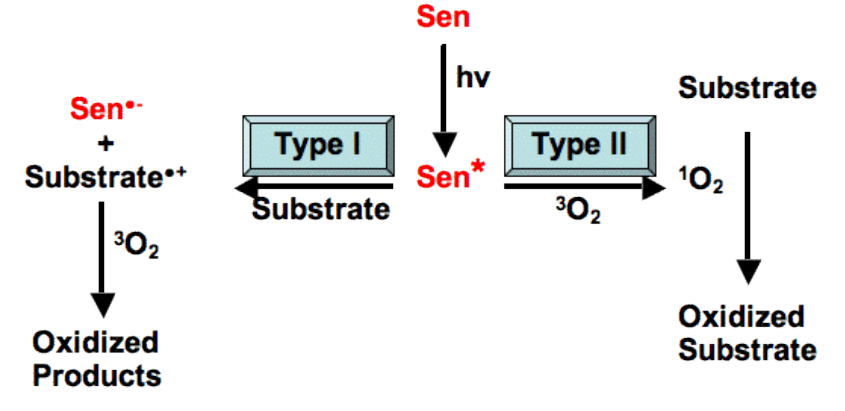
Figure 1. Type I and II chemical photosensitization. Type I: the activated sensitizer reacts with the acceptor, in a one-electron transfer reaction, to produce a radical ion in both the sensitizer and eventually in the acceptor. The acceptor (substrate) donates an electron to the sensitizer (Sen), resulting in an acceptor radical cation (Substrate+) and a sensitizer radical anion (Sen •− ), but the opposite may also occur, depending on the redox potential of the pair of molecules. In the presence of oxygen, both of these radicals can proceed to produce oxygenated products. Type II reactions: activated sensitizer transfers its excess energy to ground state molecular oxygen, producing excited state singlet oxygen and regenerating the ground-state sensitizer. Singlet oxygen then reacts with the acceptor to produce oxidized metabolites. Reprinted with permission of the author and publisher